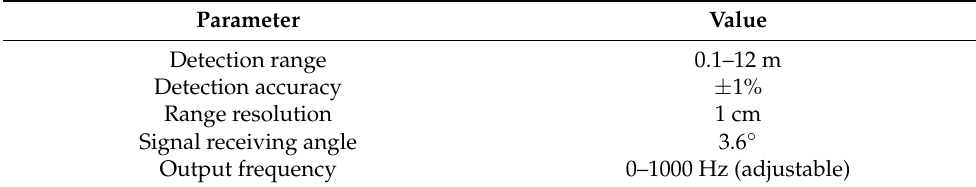
Figure 1. LiDAR sensor: ( a ) Structural schematic of the sensor, 1. Front shell; 2. Transmitting lens; 3. Receiver lens; 4. Circuit board; 5. Bolt; 6. Lens; 7. Ultrasonic welded structure; 8. Back shell; 9. Tail cable; 10. Tail cable fastener; 11. Location column; 12. Mounting hole; 13. Barbed structure; 14. Protective shield; 15; Mounting grooves; 16. Partition structure. ( b ) Signal processing circuit board. ( c ) LiDAR sensor sealed enclosure. ( d ) Final encapsulated sensor. Table 2. Parameter indicators of the LiDAR